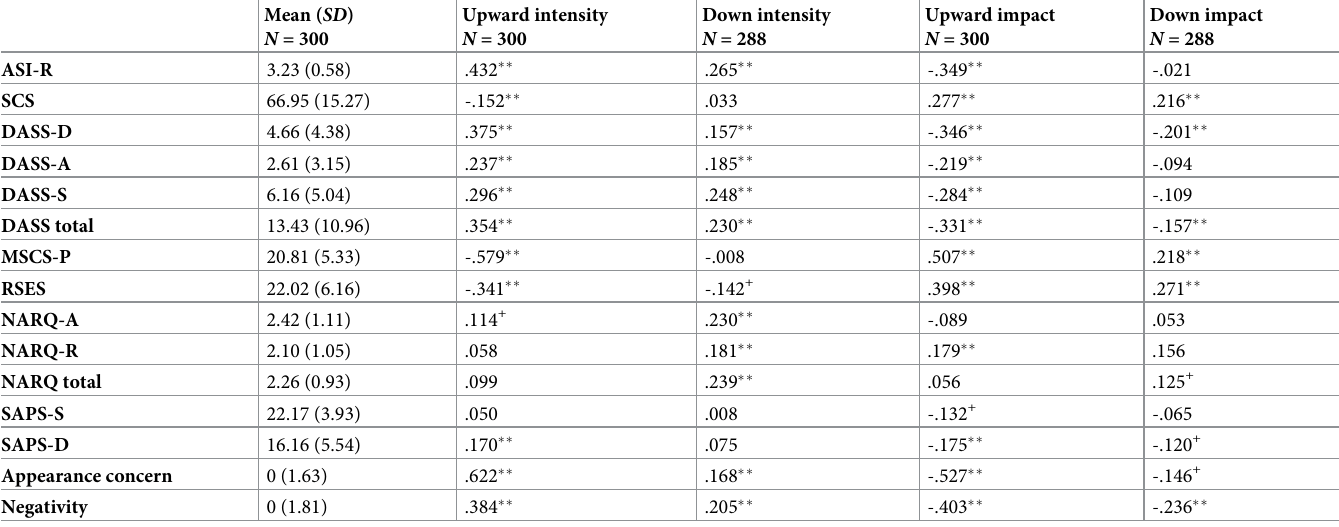
Table 4. Correlations per comparison direction and standard of CSS-A intensity and impact variables with independent and composite